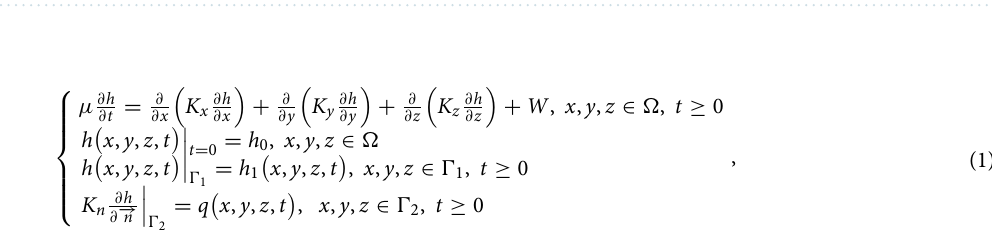
Table 2. Conversion parameters for solute concentration in each observation